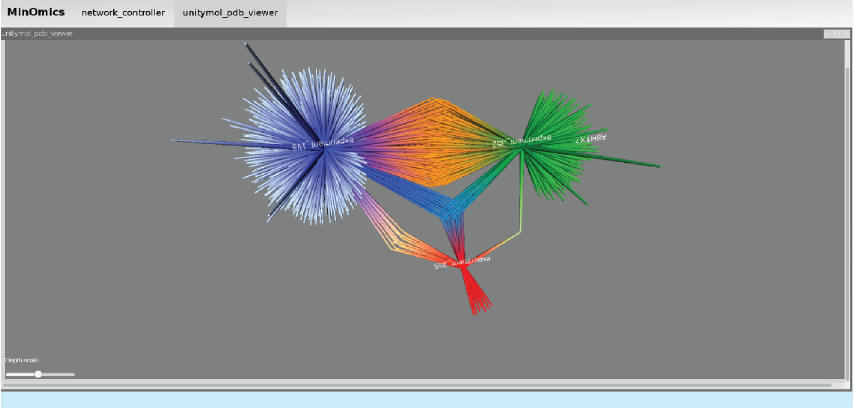
Figure 12: Redox PTMs 3D network in C. reinhardtii . The same PTM network as in Figure 11 is shown here in UnityMol af- ter extending it to 3D. We can now continuously navigate from the 2D to the 3D network. The z-axis represents the molec- ular weight as an